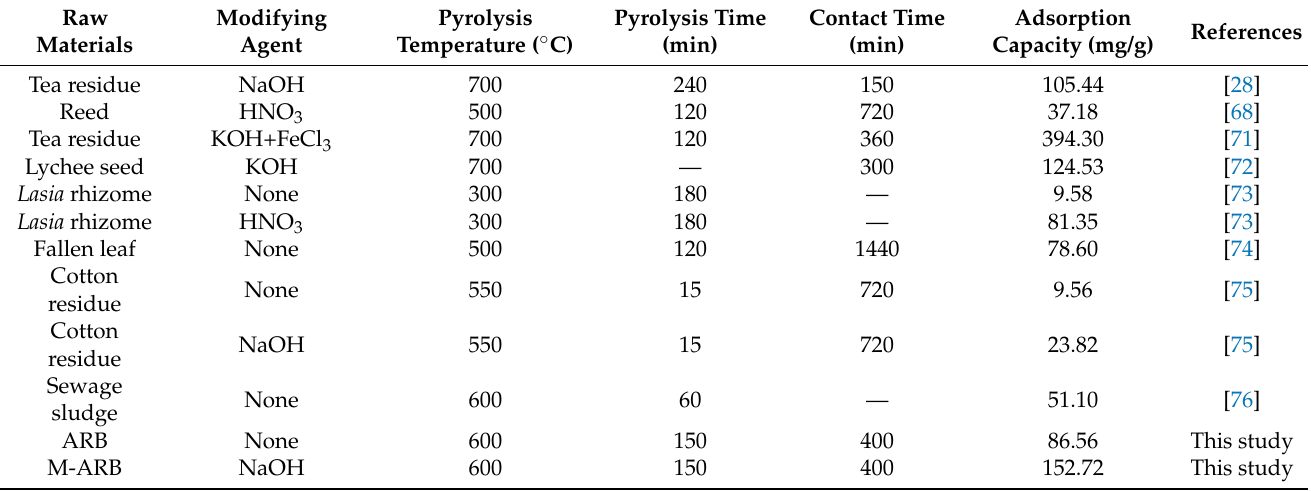
Table 7. Comparison of adsorption capacity of different biochar materials for